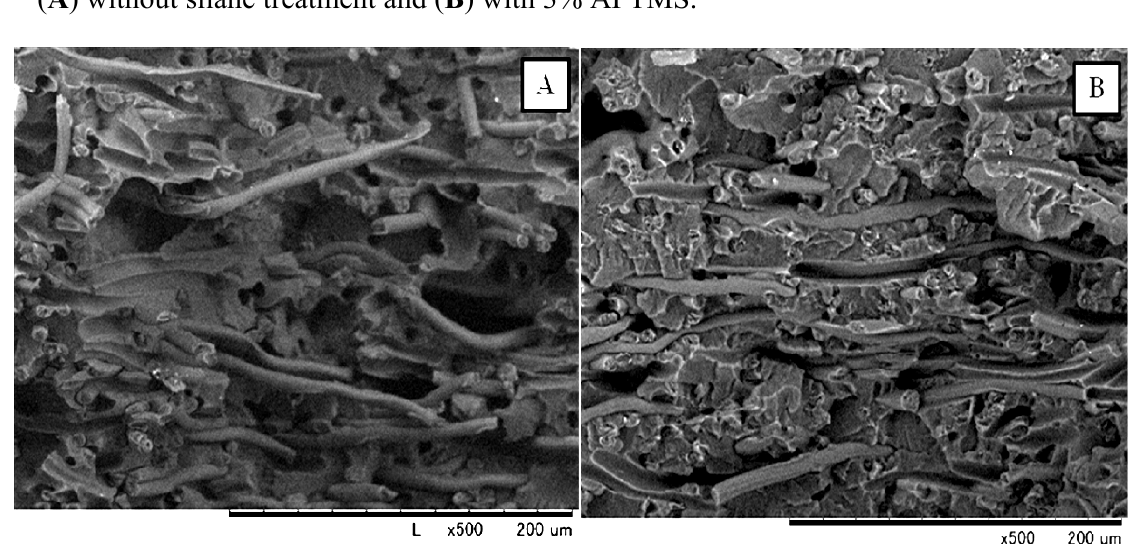
Figure 5. SEM micrographs of fracture surface of PBS/CF (60/40 wt%) composites ( A ) without silane treatment and ( B ) with 3%